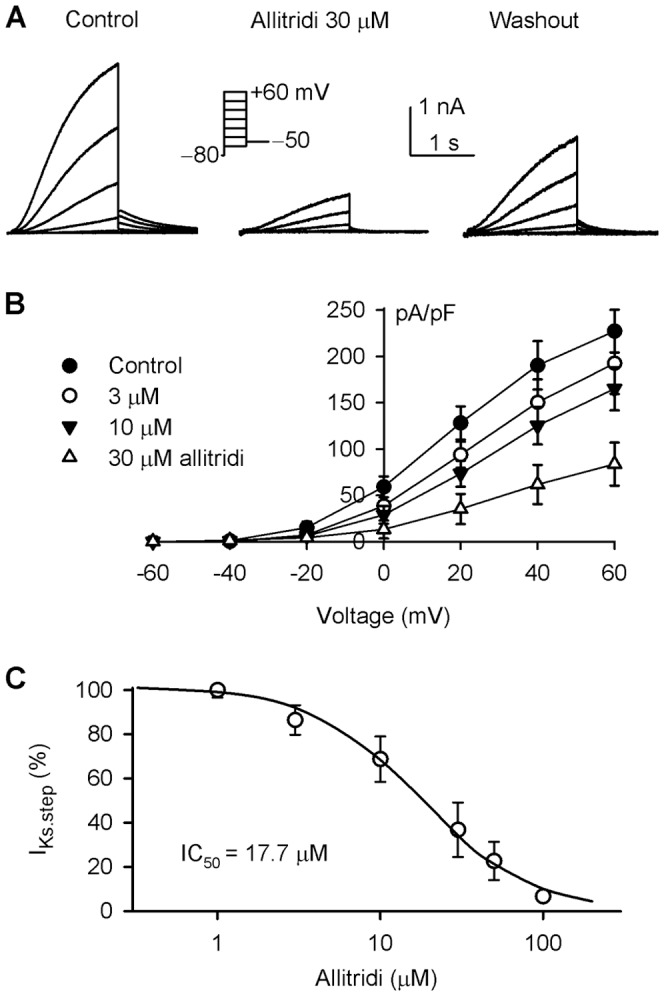
Inhibition of human cardiac IKs by allitridi.
A. Voltage-dependent human cardiac IKs recorded in a representative HEK 293 cells expressing hKCNQ1/hKCNE1 genes with the voltage protocol as shown in the inset, in the absence and presence of 30 µM allitridi. B. Current-voltage (I-V) relationships of IKs step current in the absence and presence of 3, 10, and 30 µM allitridi (n = 8, P<0.05 or P<0.01 with 30 and 100 µM allitridi vs. control at 0 to +60 mV). C. Concentration-response relationship curve of allitridi inhibiting IKs was fitted to a Hill equation (n = 5–8 for each concentration).